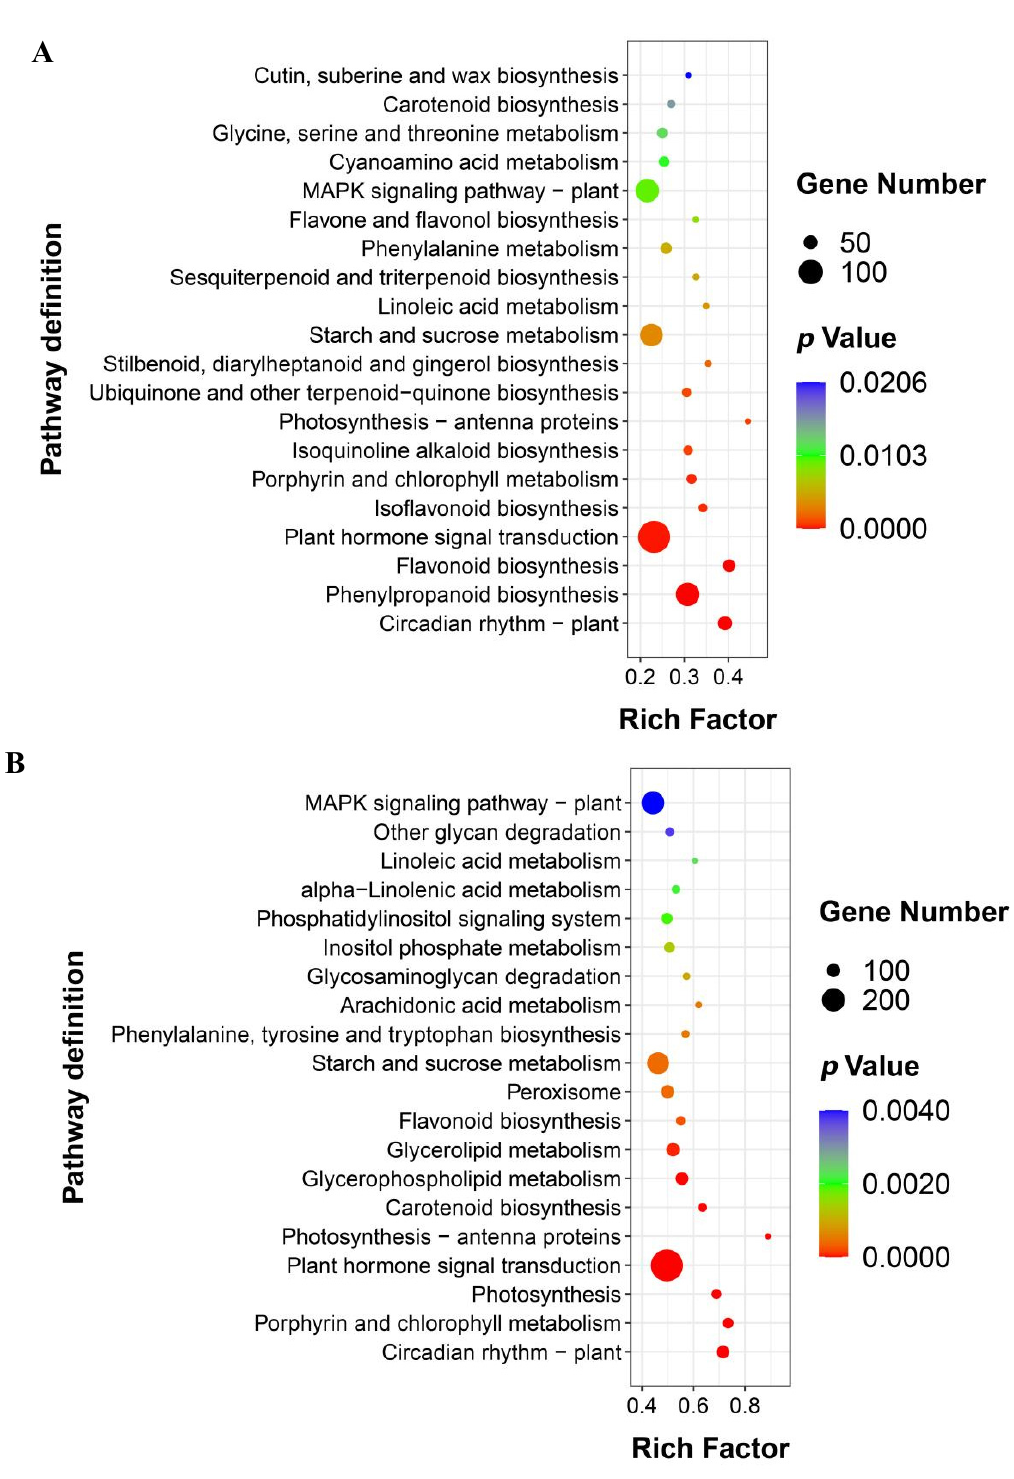
Figure 4. Kyoto Encyclopedia of Genes and Genomes (KEGG) pathway enrichment analysis of DEGs. ( A ) KEGG pathway enrichment analysis of DEGs in GUIGE8; ( B ) KEGG pathway enrichment analysis of DEGs in GUIGE18. The colors are shaded according to the p -value level, as shown in the color bars gradually changing from low (red) to high (blue). The size of the circle indicates the number of DEGs from small (less) to big (more). The larger the rich factor, the higher the GO enrichment degree.